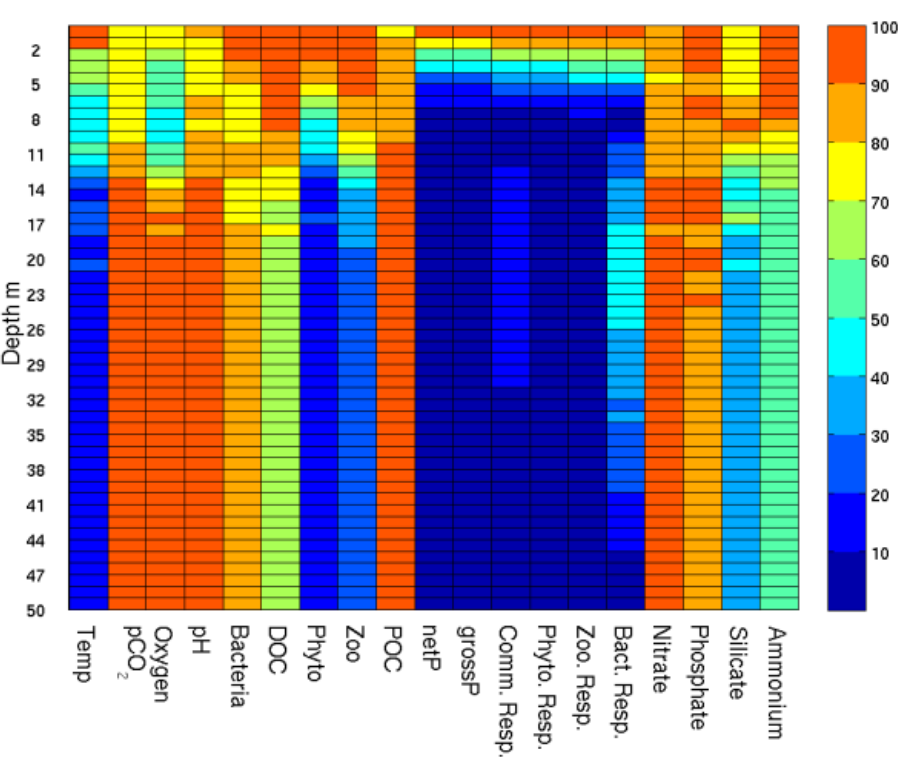
Figure 11. Distribution with depth of the averaged 2008–2009 root mean square error between Experiment A and B for selected variables. The values are percentage change with respect to the maximum value for each variable. The higher values in the top 10 m indicates differences between the two models are concentrated